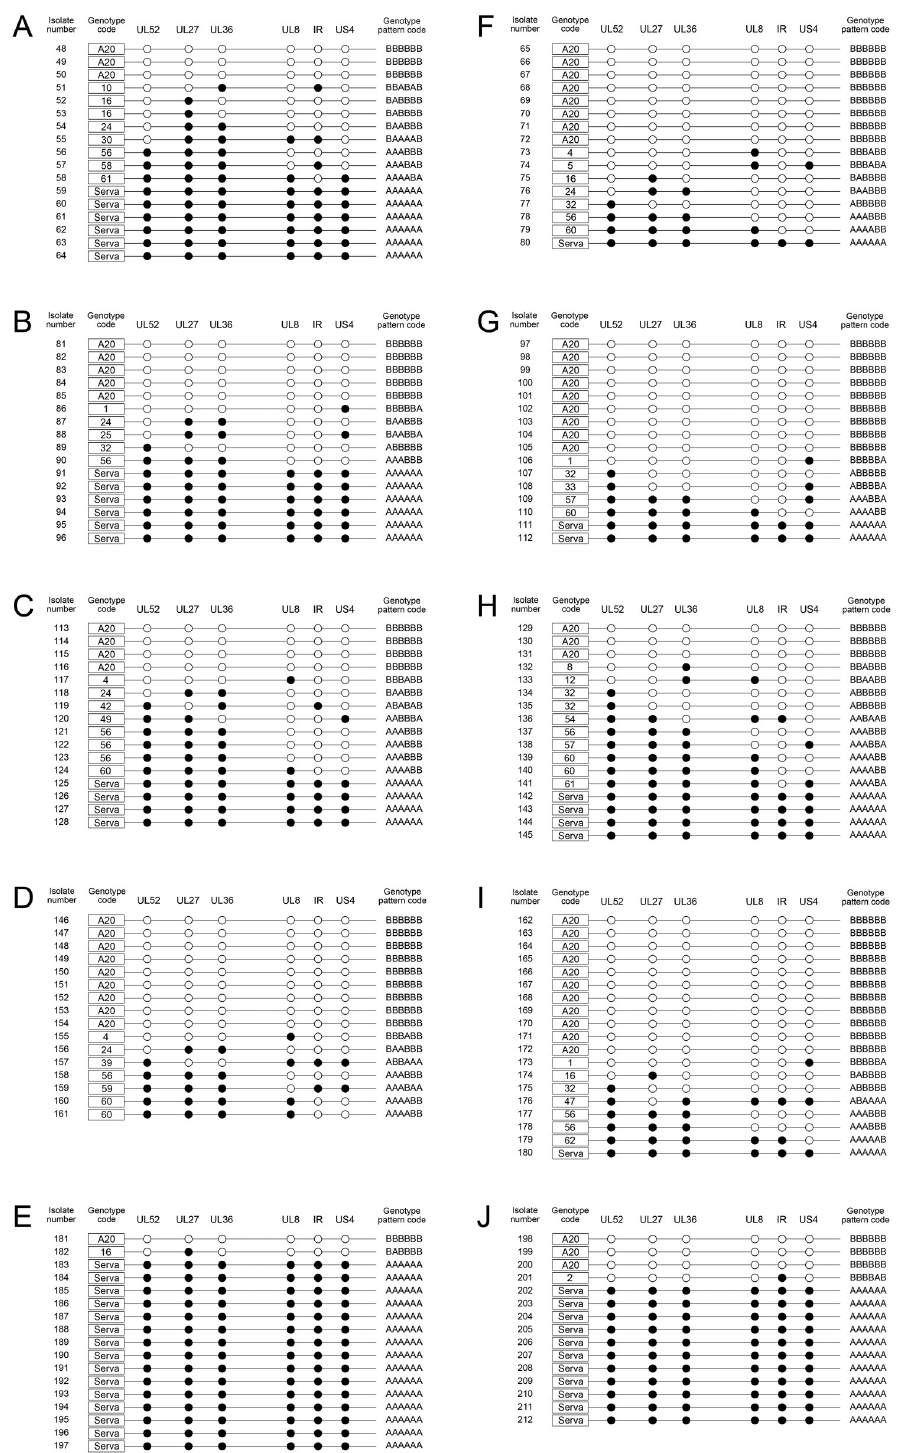
Fig 3. Schematic view of SNP distribution, showing the composition of the progeny population collected from the CAM (left column = A, B, C, D and E) and AF (right column = F, G, H, I and J) of co-infected chicken embryos 72 hours after inoculation. Five eggs were inoculated per group and the viruses were isolated from 3 or 4 eggs (pooled samples) that did not show any signs of embryonic death. The panels represent each ratio of infecting parent viruses (Serva:A20) as 1:1 (A, F), 1:2 (B, G), 2:1 (C, H), 1:10 (D, I) or 10:1 (E, J). The closed circles indicate Serva-like SNPs